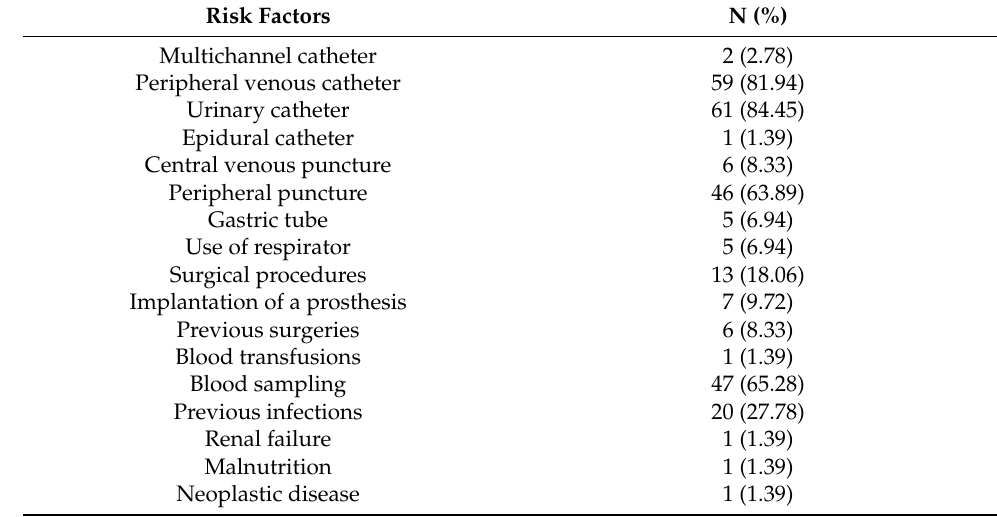
Table 5. Influence of different risk factors on the development of nosocomial infections and their number.